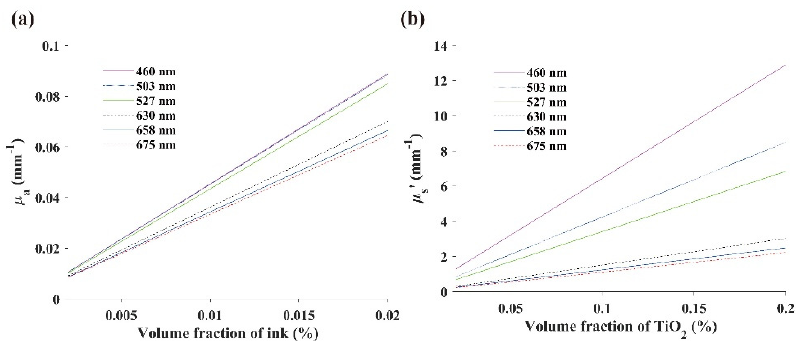
Figure 7. Reference values for phantom optical properties: ( a ) reference values of μ a ; ( b ) reference values of μ ’ s .